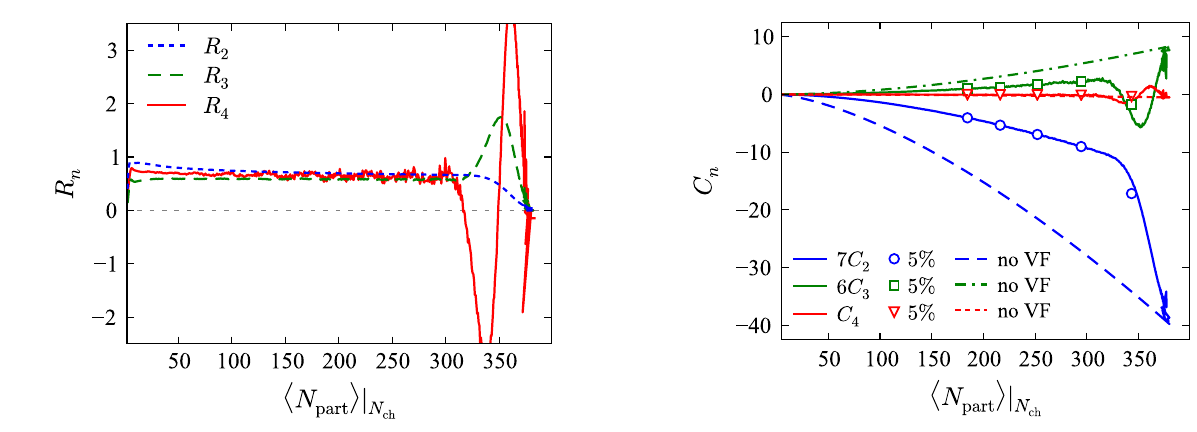
Fig. 3 Multi-particlecorrelations C n inAu+Aucollisionsat GeV. The leading terms, where fluctuations of the number of wounded nucleonsarenotpresent,aredenotedby“noVF”.Alsoshownas circles , triangles and squares are the results for the five most central bins with a width of 5% of centrality